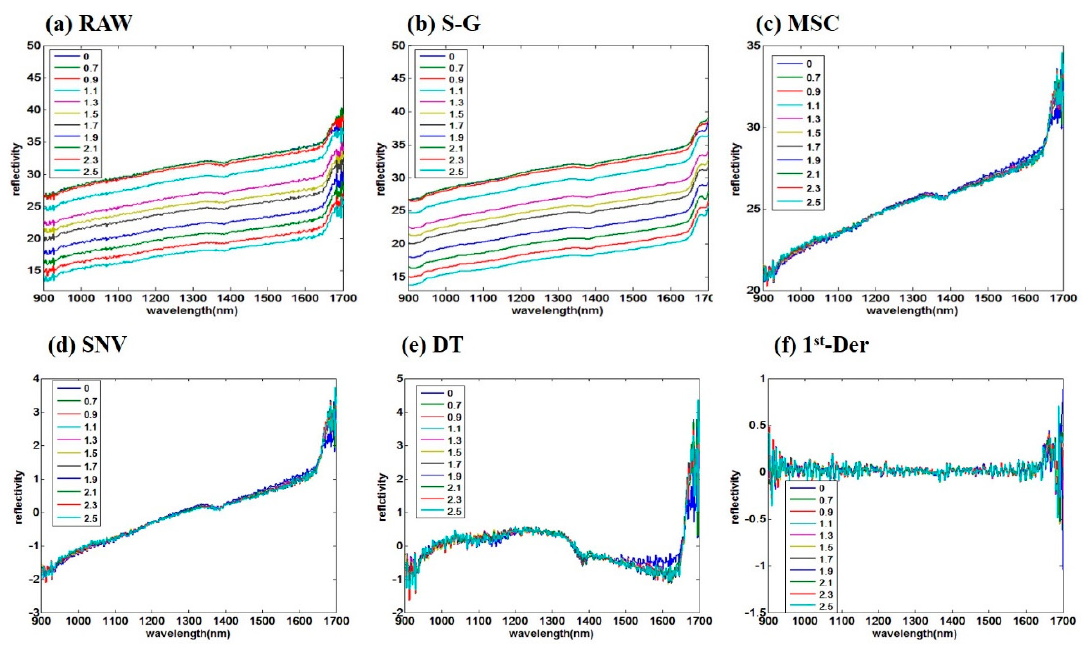
Figure 1. Soil average spectra with different spectra pretreated after drying at 40 °C. ( a ) The raw spectra; ( b ) the spectra after Savitzky–Golay (S–G) smoothing pretreatment; ( c ) the spectra after multiplicative scatter correction (MSC) processing; ( d ) the spectra with standard normal variation (SNV) pretreatment; ( e ) the detrending (DT)-treated spectra; ( f ) the spectra after 1st-Derivation (1st-Der).